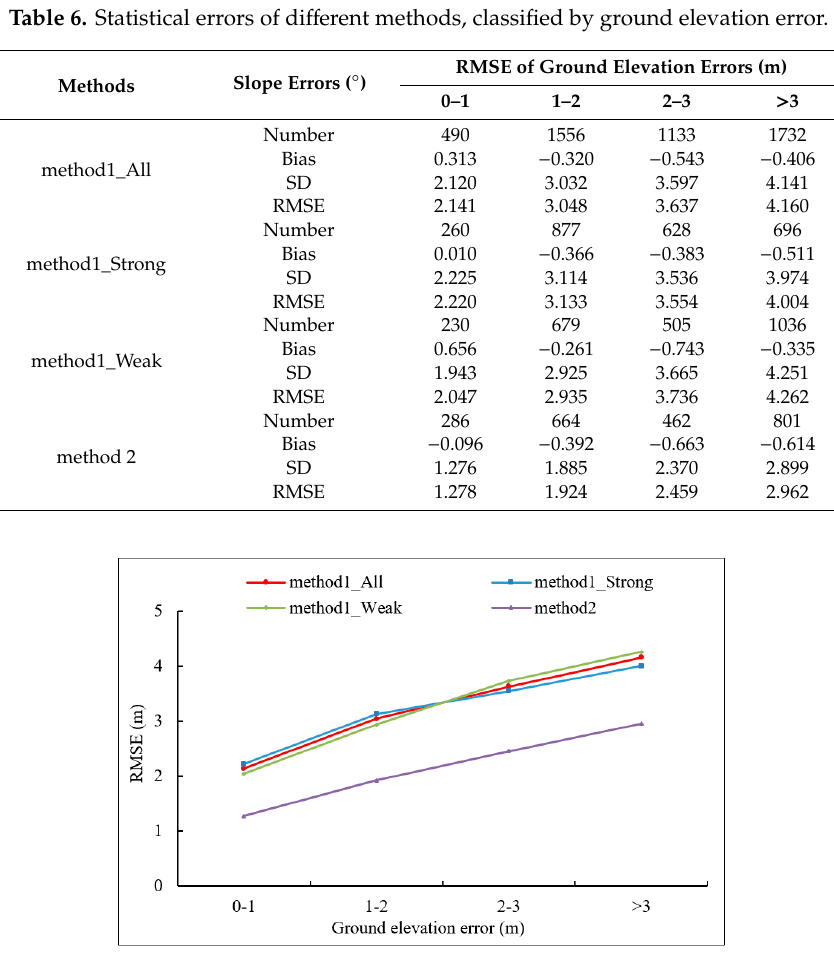
Figure 9. The effect of ground elevation error on terrain slope retrieval. Figure 9. The e ff ect of ground elevation error on terrain slope